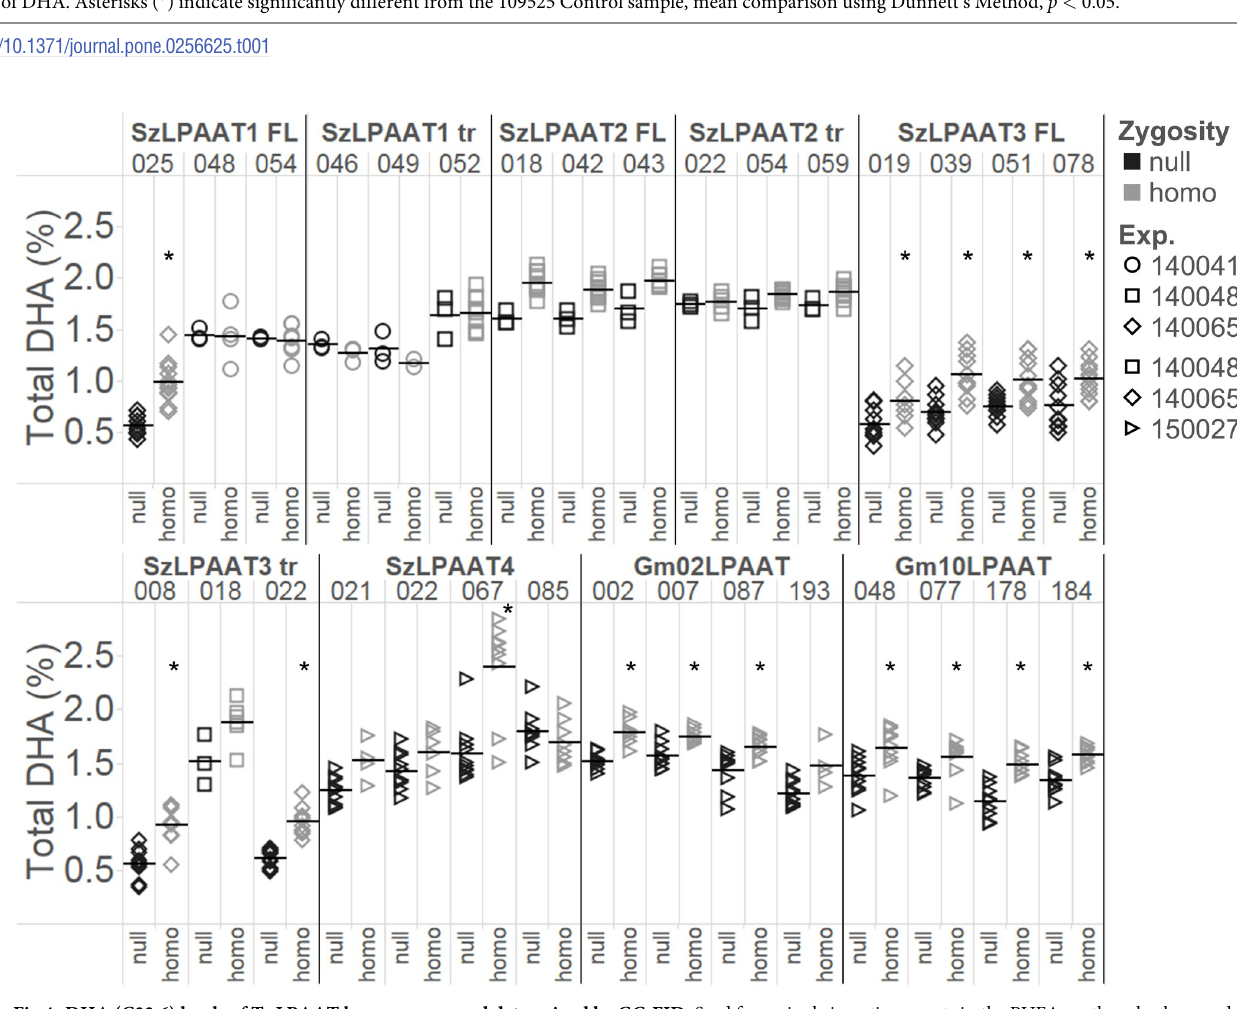
Fig 4. DHA (C22:6) levels of T 3 LPAAT homozygous seed determined by GC-FID. Seed from single insertion events in the PUFA synthase background were compared with segregating null seed. Percentages are in weight % of total fatty acid methyl esters. The horizontal line represents the mean for